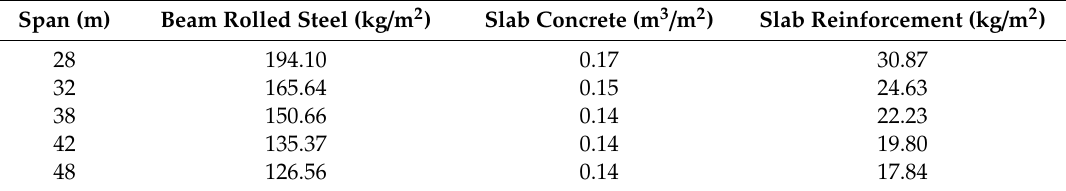
Table 8. GSO with DLS combination measurements of the materials for 28, 32, 38, 42, and 48 m spans. Span